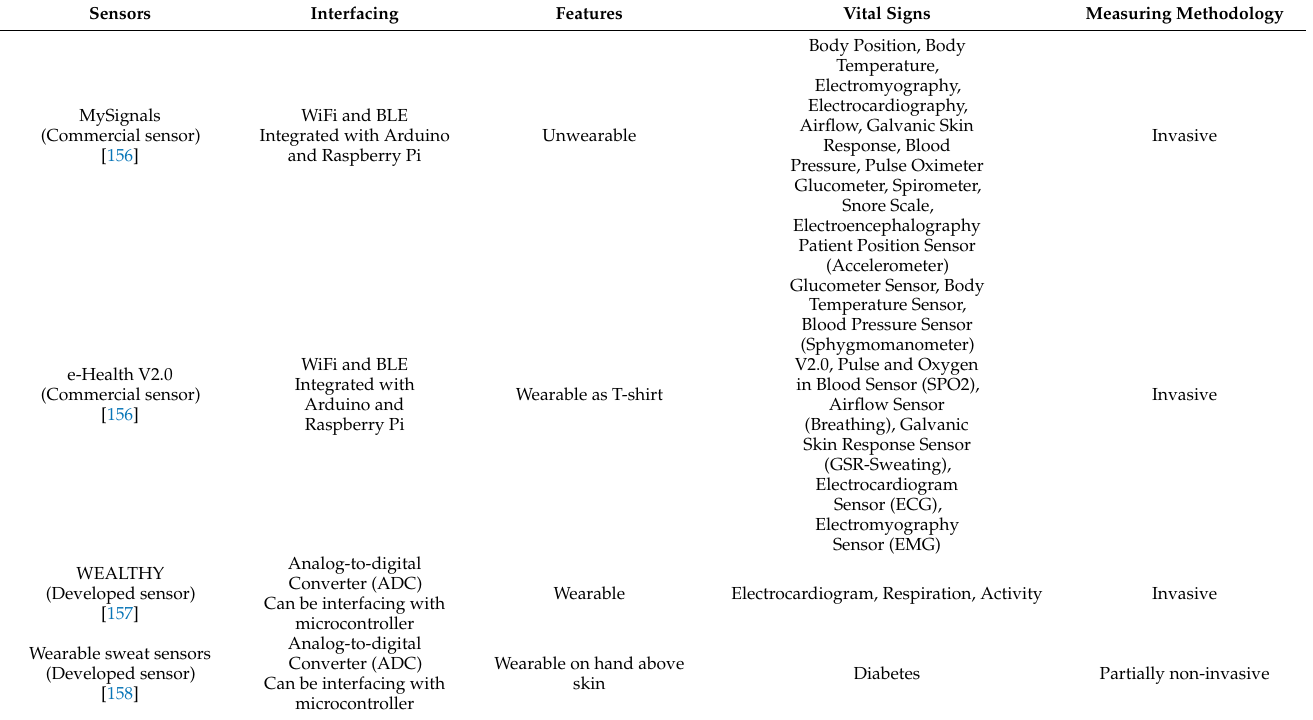
Table 2. Different sensing techniques and technologies for human vital